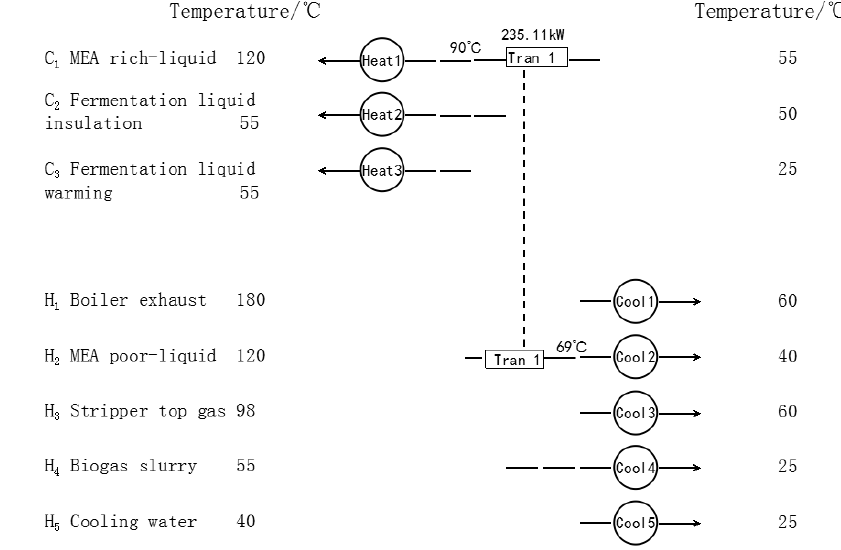
Figure 3. Heat exchanger network of the system.